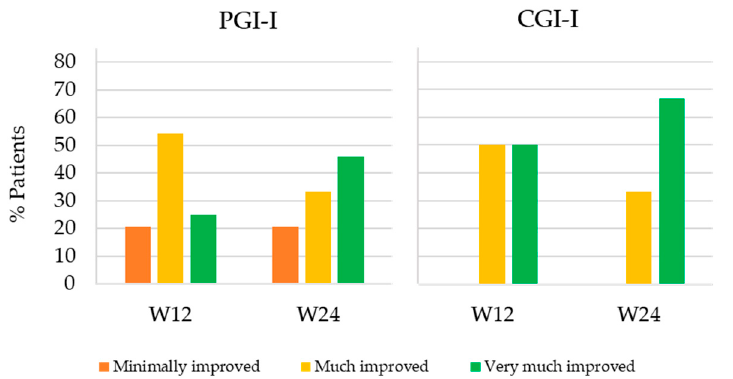
Figure 3. Percentage of patients that minimally improved, much improved and very much im-